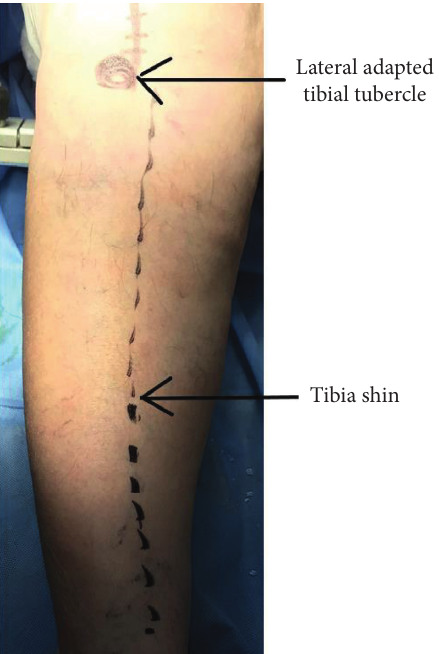
Figure 4: Case with lateral adapted tibial tubercle.